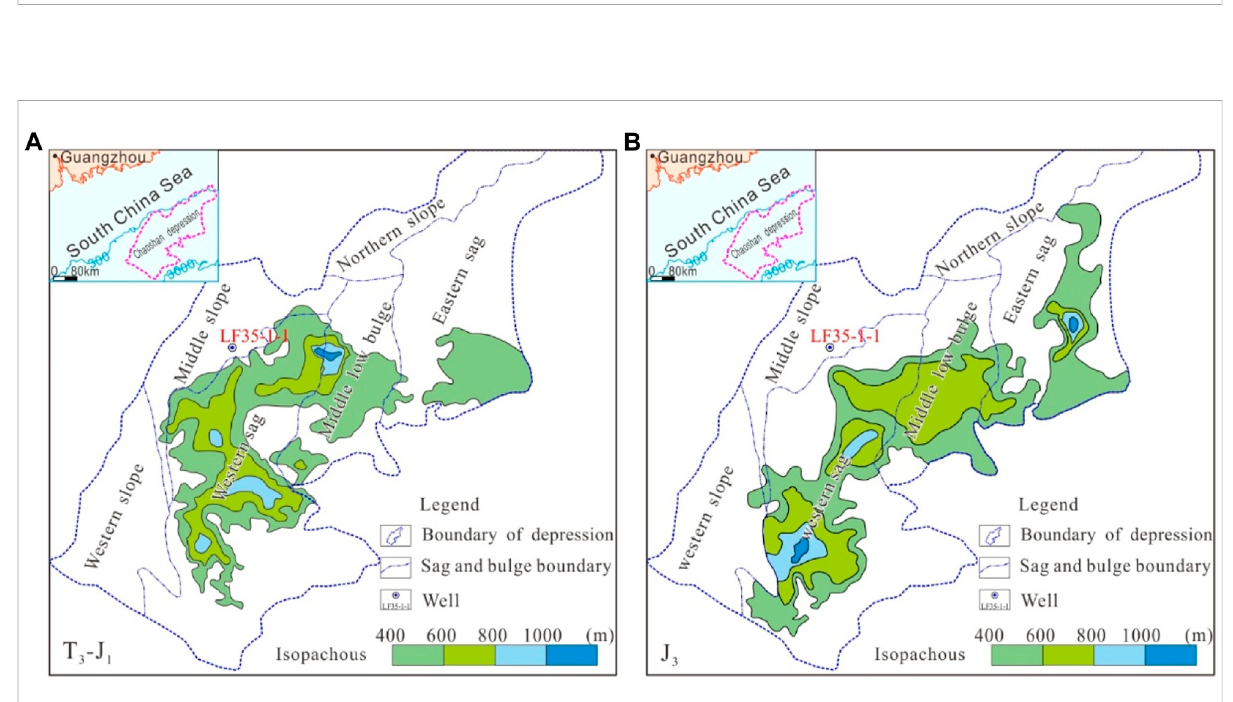
FIGURE 5 Map of mud rock thickness of the two effective source layers in the Chaoshan depression. (A) Map of mud rock thickness of T 3 -J 1 ; (B) Map of mud rock thickness of J 3 .